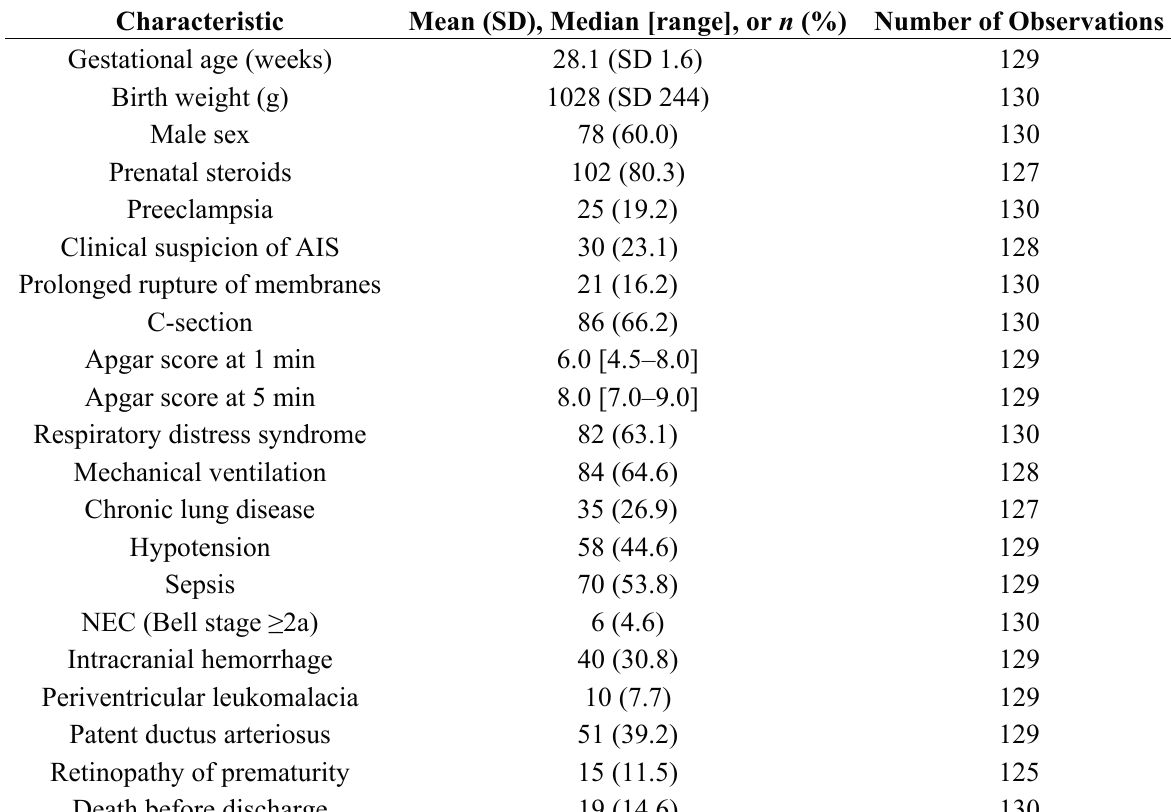
Table 1. Demographic characteristics and outcomes of the included